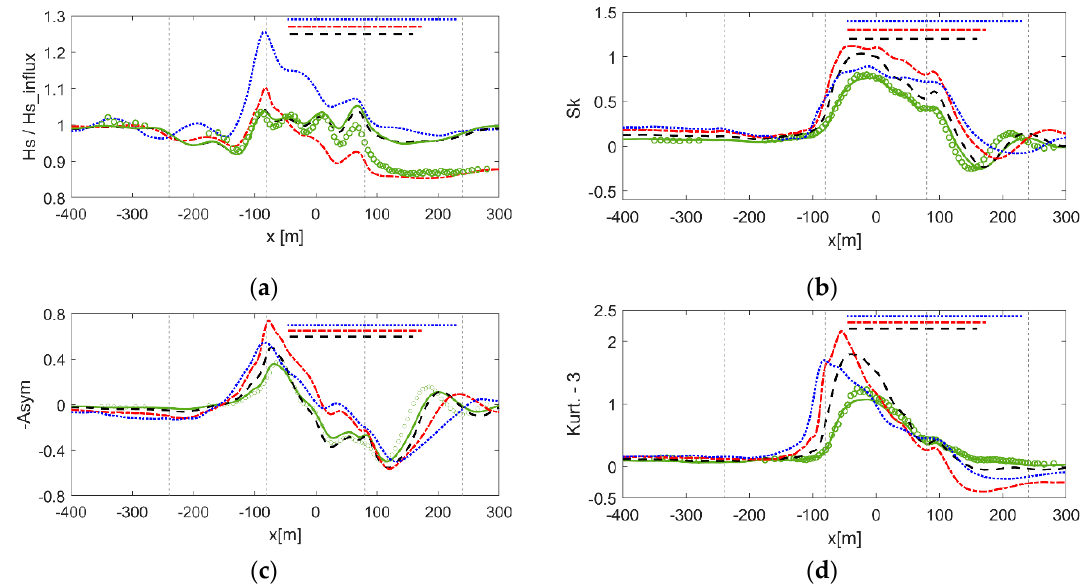
Figure 16. Comparison of the statistical quantities over the area for the four 1D long-crested cases: ( a ) Hs divided by the influx value, ( b ) Skewness, ( c ) Asymmetry, and ( d ) the excess Kurtosis. The experimental data for H2.5T11 (green circle) and the simulation (green solid line), and also Hs4T11 (black-dashed), H6T12 (red dash-dot), and H7.5T14 (blue-dot), are shown. The horizontal bars on top of each plot indicate the area of breaking for the three breaking cases.